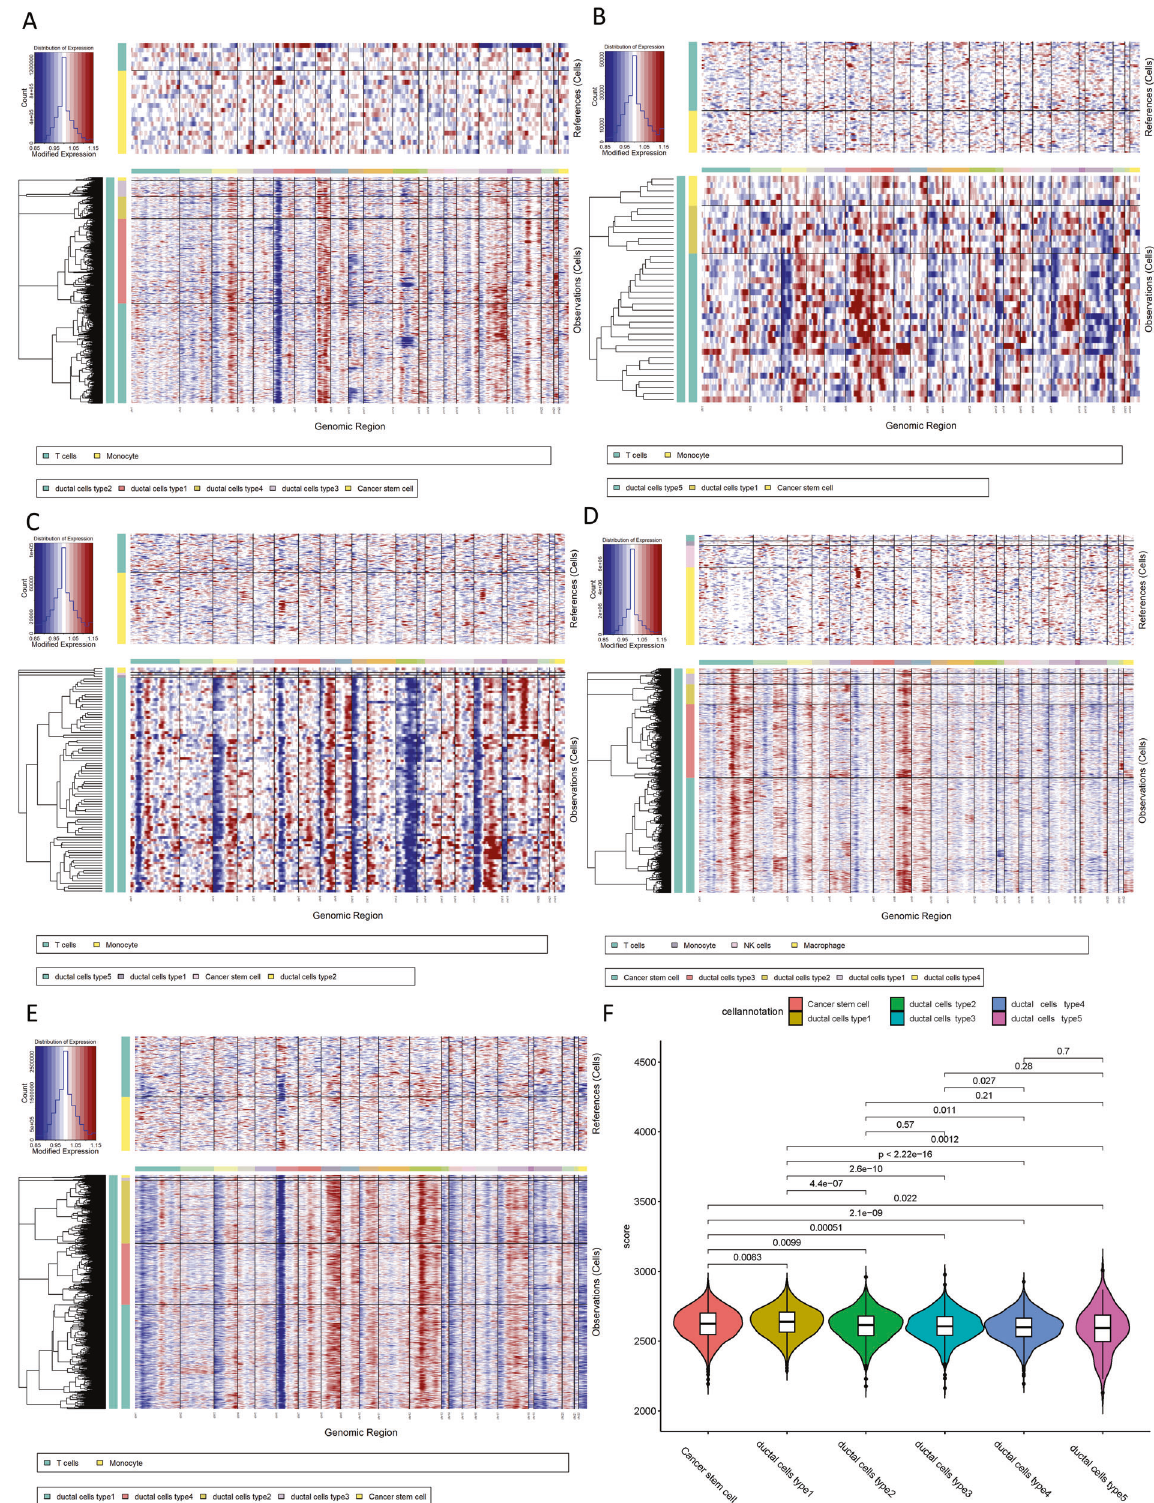
Fig. 2 Copy-number variation analysis of PDAC cells. A The hierarchical heatmap showing large-scale CNVs in tumor lesions form one metastatic PDAC sample (MET1). B The hierarchical heatmap showing large-scale CNVs in tumor lesions form one metastatic PDAC sample (MET2). C The hierarchical heatmap showing large-scale CNVs in tumor lesions form one metastatic PDAC sample (MET3). D The hierarchical heatmap showing large-scale CNVs in tumor lesions form one metastatic PDAC sample (MET4). E The hierarchical heatmap showing large- scale CNVs in tumor lesions form one metastatic PDAC sample (MET5). F Violin plots showing distributions of CNV scores among different cell types.